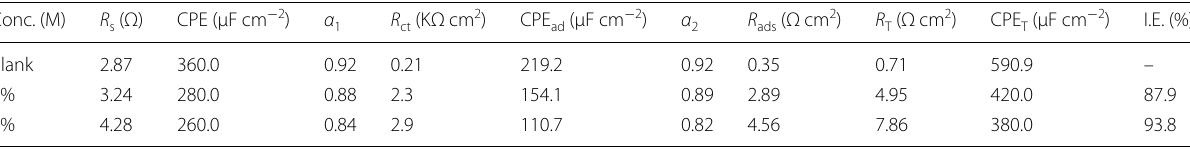
Table 4 Parameters of electrochemical impedance results for cast iron in 3.5 wt% NaCl in the absence and presence of different concentrations of polyurethane at ambient temperature Conc.